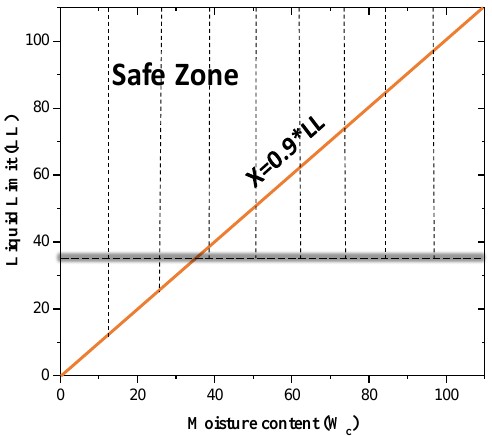
Figure 1: Safe liquefaction area in fine soils according to Wang criterion